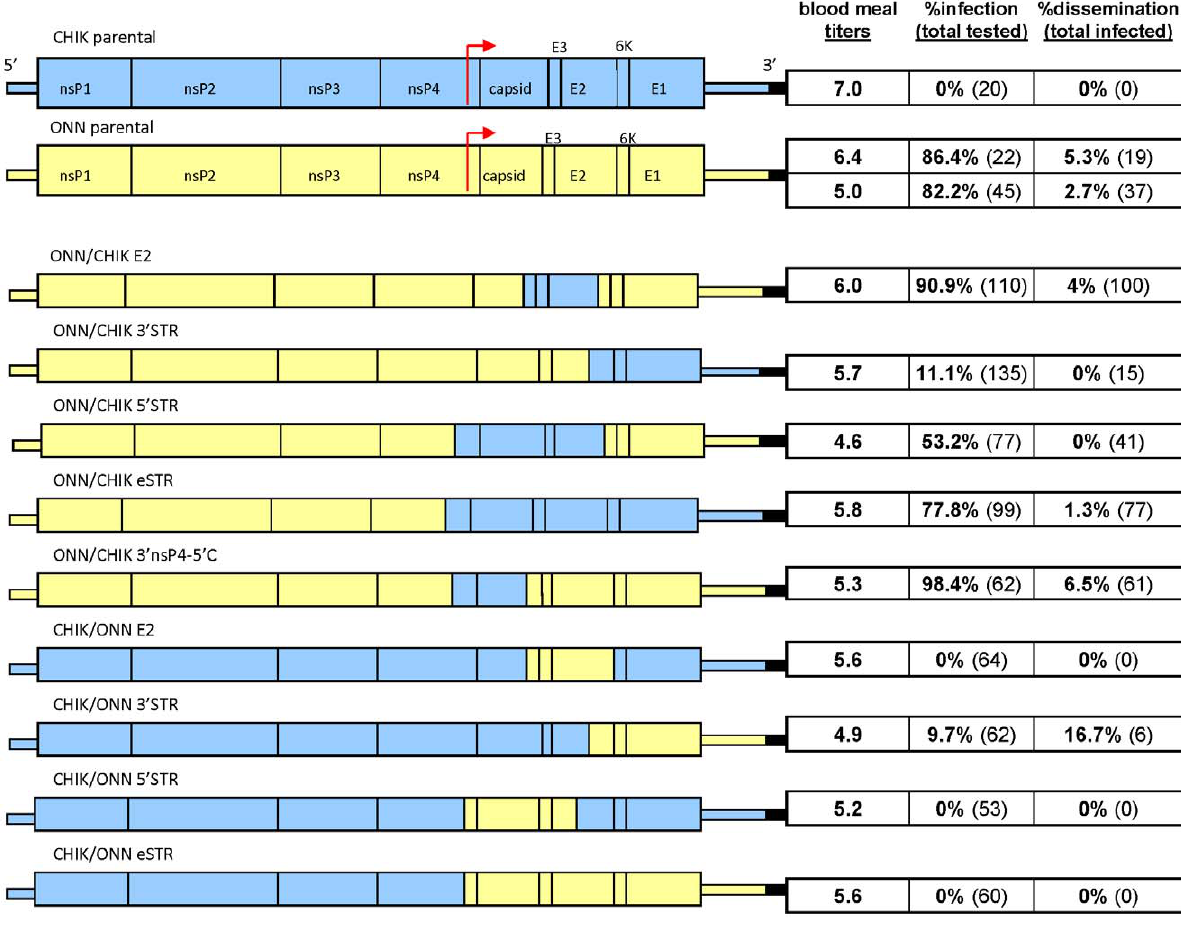
Figure 1. Infection rates with schematic diagrams. Infection rates at day 8 post-infection with parental and structural-region chimeric viruses in An. gambiae . Results from the 2–3 replicate feeds were combined and the titer (log 10 PFU/ml) shown is an average (for titers that were within 0.5 log 10 PFU/ml of one another). Infection rate is determined using mosquito bodies while dissemination rate is derived from heads.